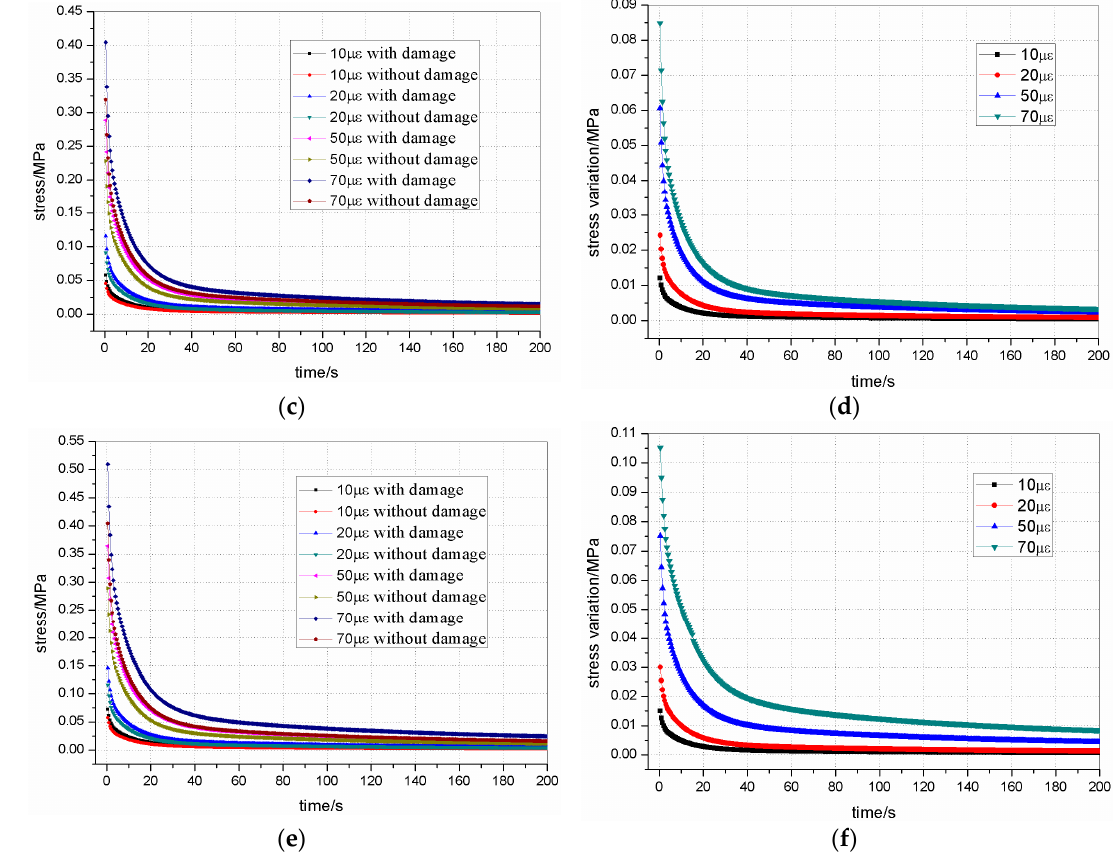
Figure 12. The von Mises stress and variation at three locations in the digital sample: ( a ) The von Mises stress at location 1; ( b ) the von Mises stress variation at location 1; ( c ) the von Mises stress at location 2; ( d ) the von Mises stress variation at location 2; ( e ) the von Mises stress at location 3; and ( f ) the von Mises stress variation at location 3.